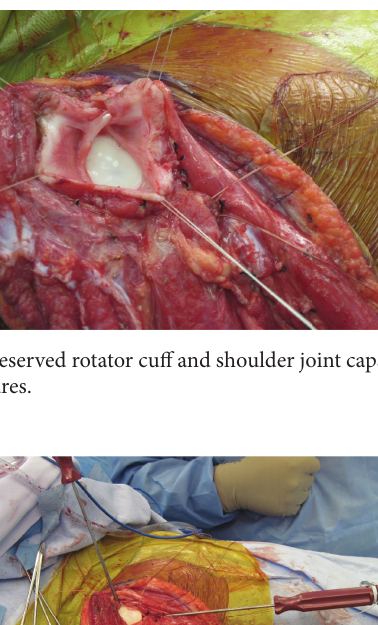
Figure 9: Endoprosthesis following ulnar cementation, suturing of rotator cuff to vascular graft, and imbrication of the vascular graft with nonabsorbable sutures.